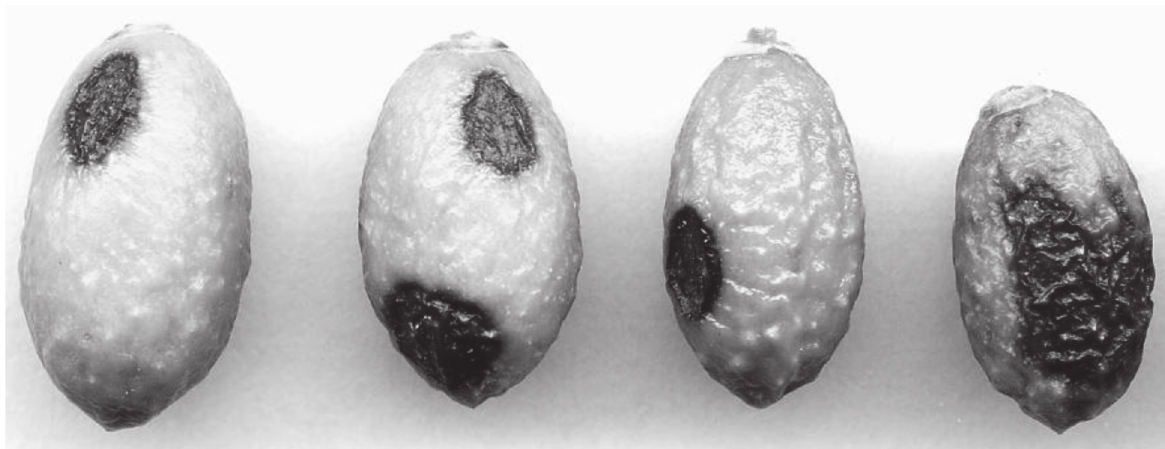
Figure 3. Typical symptoms of Colletotrichum gloeosporioides after inoculation on